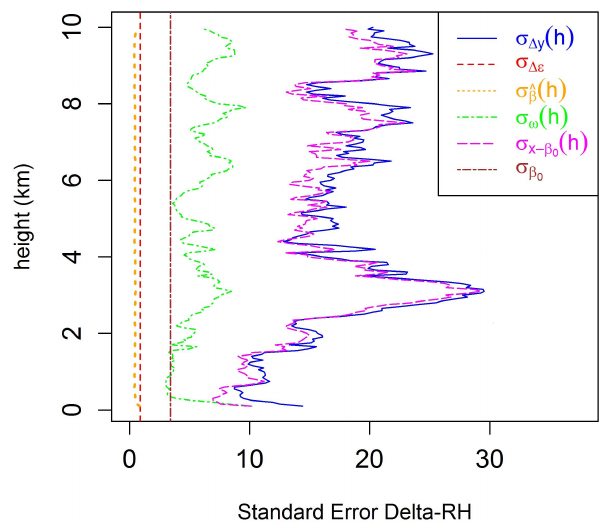
) budget for relative y ) , µ ) , irreducible environ- β ) and con- 0